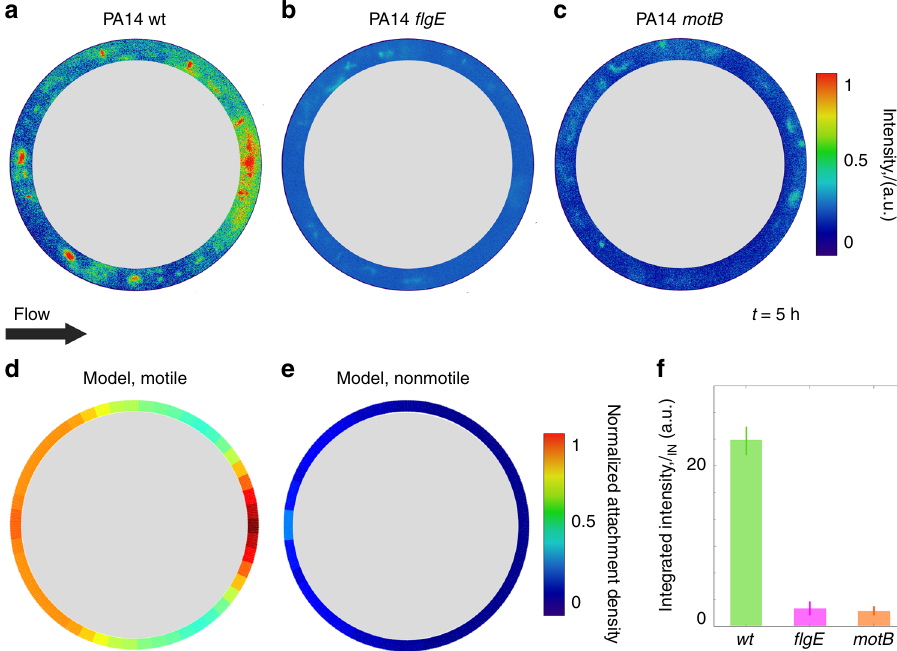
Fig. 2 Surface colonization on pillars by P. aeruginosa is determined by bacterial motility. Intensity distribution of the fl uorescent signal from GFP-tagged motile (PA14 wt, a ) and nonmotile (PA14 fl gE , b ; PA14 motB , c ) P. aeruginosa cells attached to a 100- µ m pillar after 5 h fl ow at a rescaled fl ow velocity of U/V = 6.6. d, e Angular distribution of the normalized attachment density of bacteria on the pillar obtained with a mathematical model for motile ( d ) and nonmotile ( e ) cells for the same fl ow rate and pillar dimension as a – c . f Integrated intensity, I IN obtained for the motile (wt) and nonmotile ( fl gE , motB ) strains from the images in a – c . Error bars correspond to the standard error of the